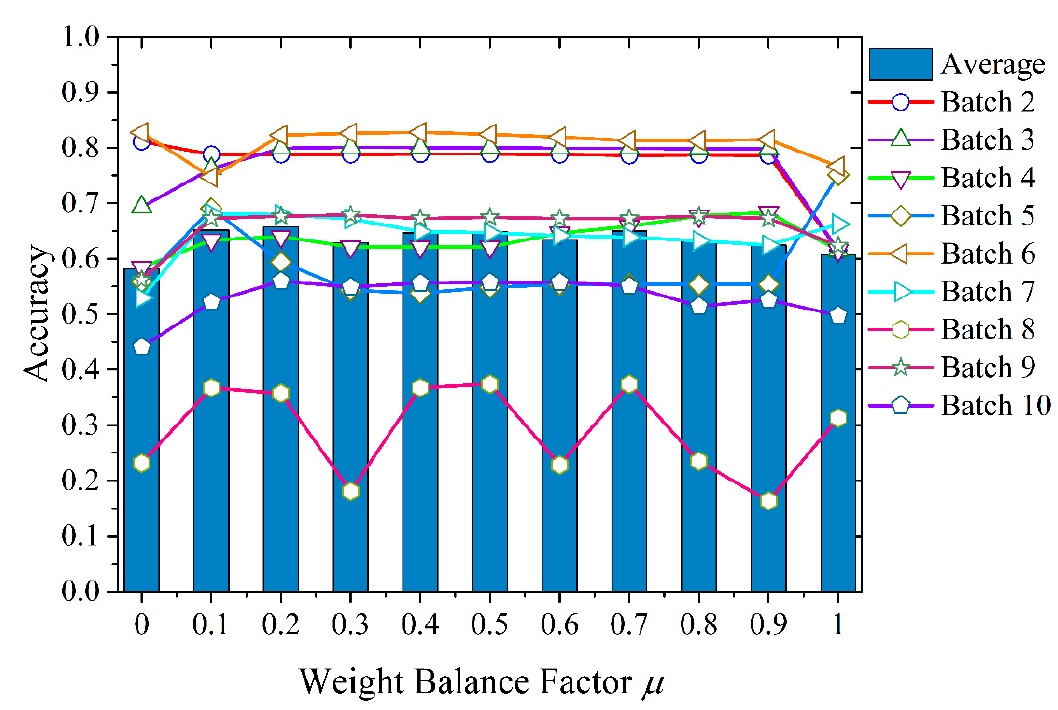
Figure 6. The impact of different weight balance factors µ on classification accuracy. Obviously, the optimal value of weight balance factor µ varied in different data